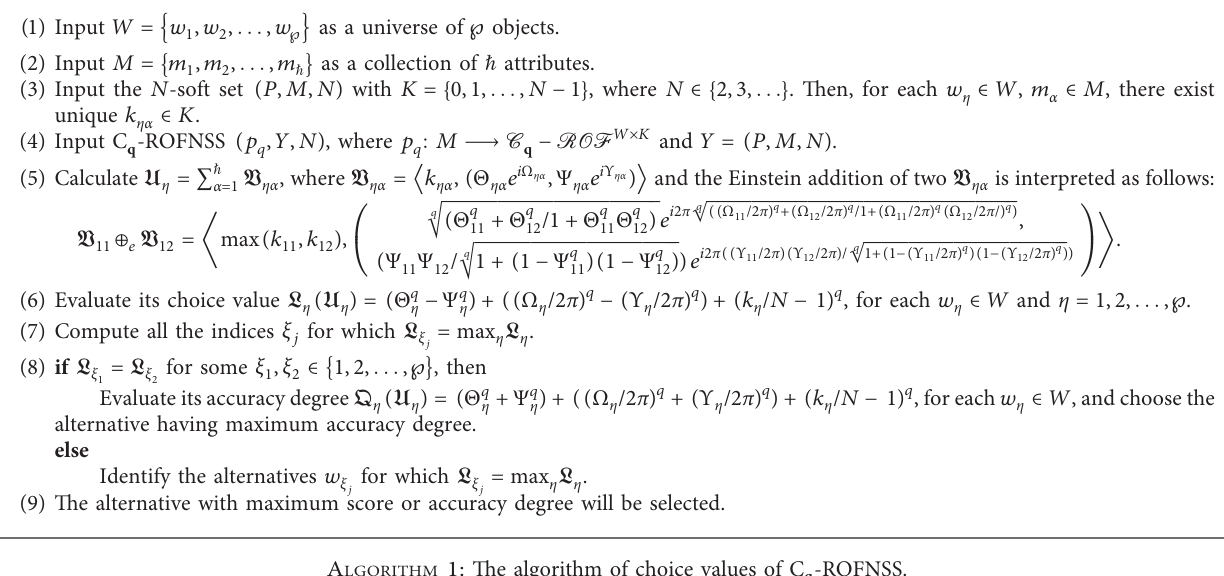
A LGORITHM 1: The algorithm of choice values of C